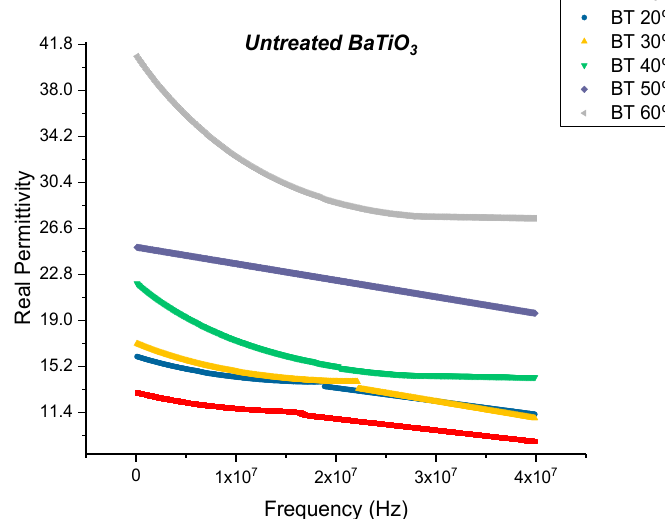
Figure 3. The real permittivity of the BaTiO 3 -epoxy composite that were fabricated using untreated BaTiO 3 nanoparticles is plotted as a function of frequency where the volume fraction of BaTiO 3 is varied from 10% to 60%. This value at 20 MHz attains a maximum of 28.70 at 60% volume fraction of BaTiO 3 .